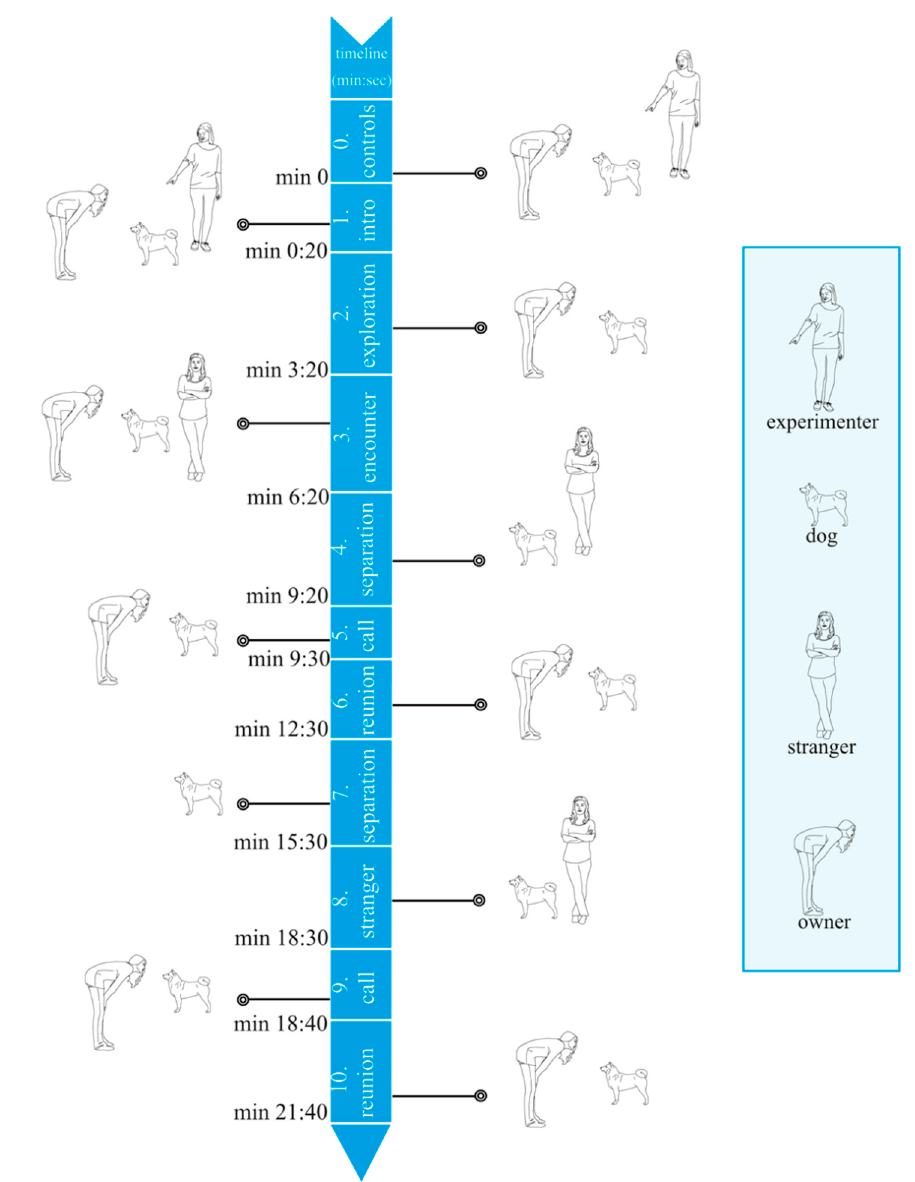
Figure 1. The Ainsworth strange situation (ASS) procedure visualized in the form of a timeline. The icons represent all parties of this study. The dog was present at all times and is therefore marked as such in each episode. The episodes marked with the owner icon were used for audio analysis.